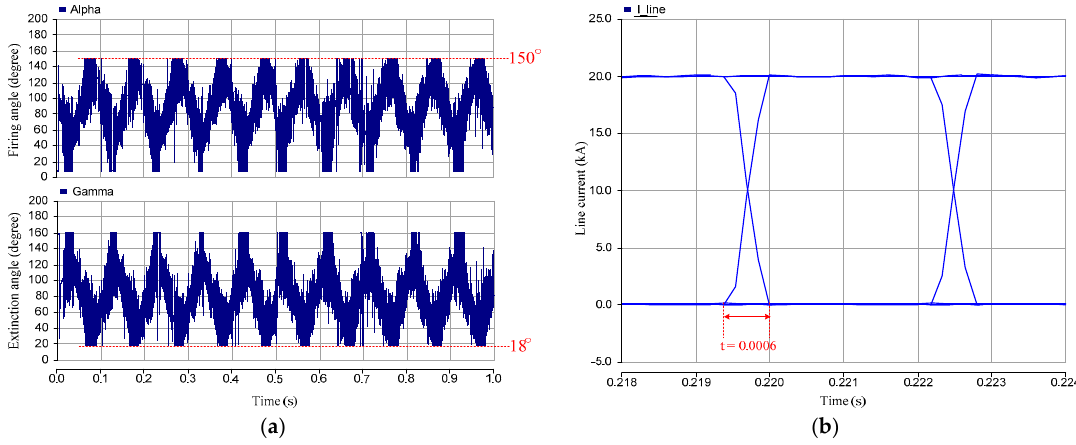
Figure 17. Simulation result of extinction control. ( a ) Firing angle and extinction angle during operation at 20 kA; and ( b ) line current waveforms.